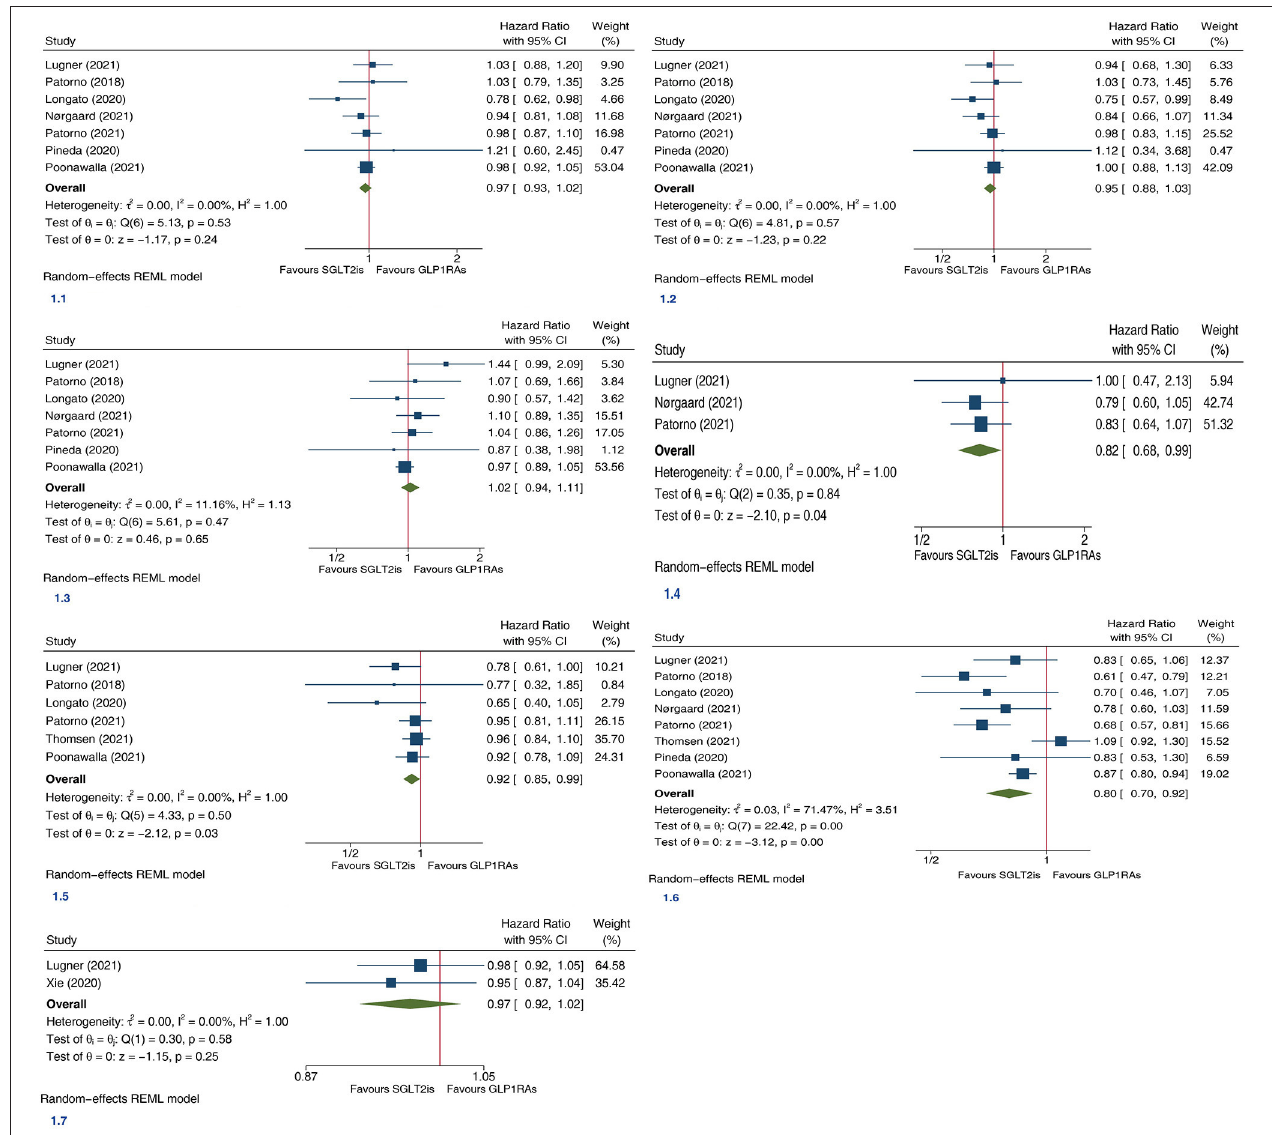
FIGURE 1 | Forest plots of the efficacy of SGLT2is vs. GLP1RAs on seven ( 1.1 , Major adverse cardiovascular events; 1.2 , myocardial infarction; 1.3 , stroke; 1.4 , cardiovascular death; 1.5 , all-cause mortality; 1.6 , hospitalization for heart failure; 1.7 , composite kidney outcome) cardiorenal and death endpoints in patients with type 2 diabetes. SGLT2is, sodium-glucose cotransporter 2 inhibitors; GLP1RAs, glucagon-like peptide-1 receptor agonists; CI, confidence interval; REML, maximum likelihood